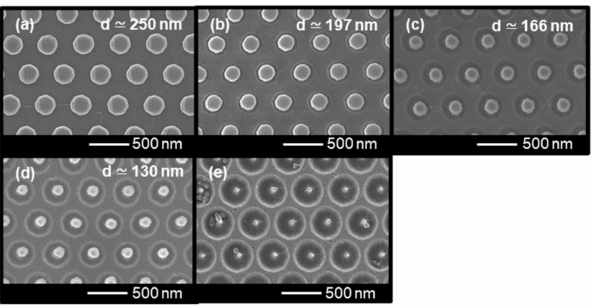
Figure 2. SEM images of re-shaped COP molds processed over different etching times: ( a ) 0 min, ( b ) 5 min, ( c ) 10 min, ( d ) 15 min, and ( e ) 20 min. The d value in each figure indicates the average values of measured diameters of nanopillars. The white dashed circles indicate the broken parts of nanopillars.